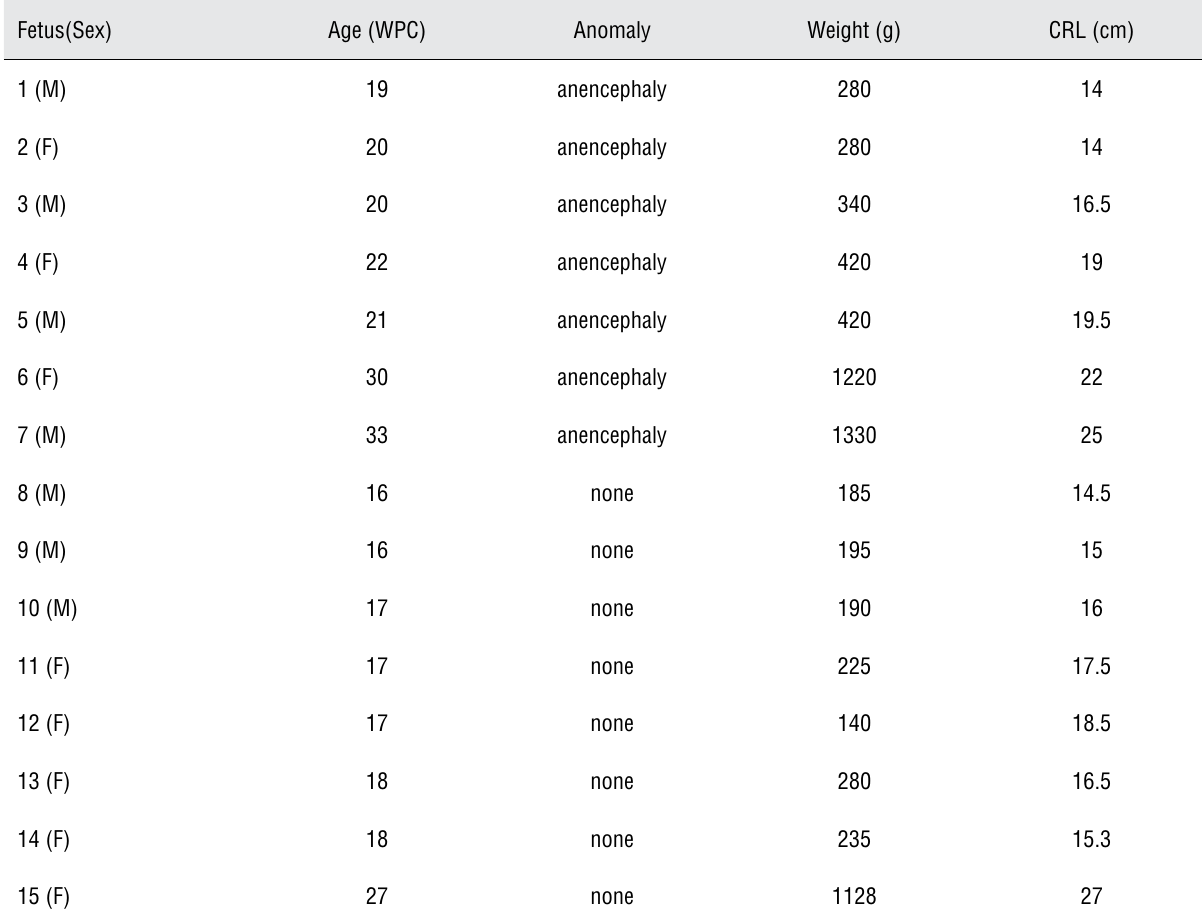
Table 1 - Age and fetal parameters of the sample. Fetus(Sex) Age